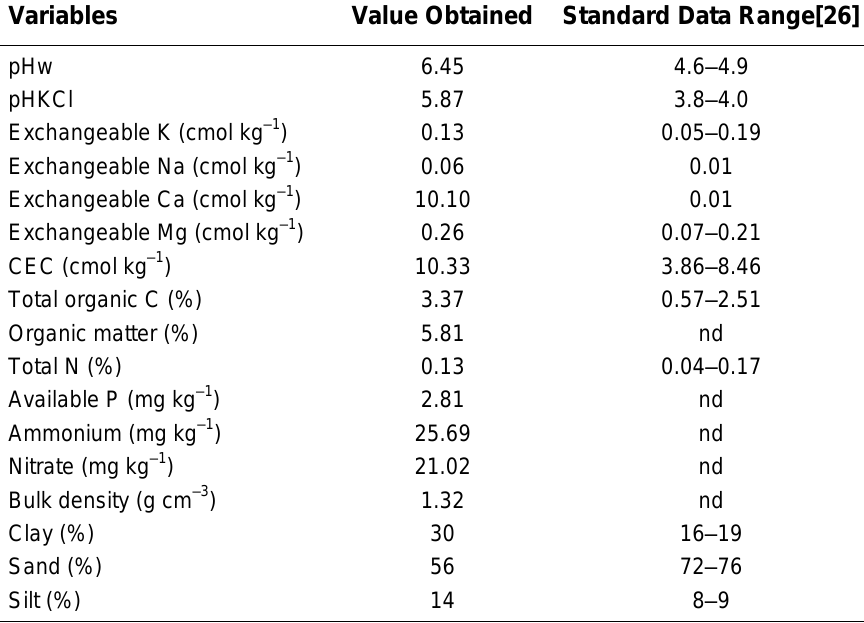
Selected Physicochemical Characteristics of Bekenu Series